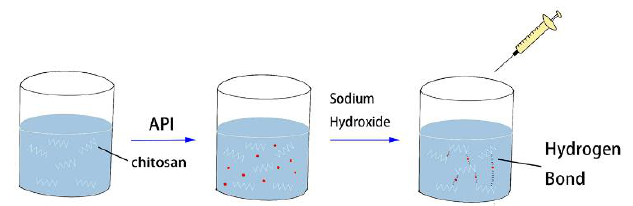
Figure 1. Preparation of BER/CS and PHI/CS.